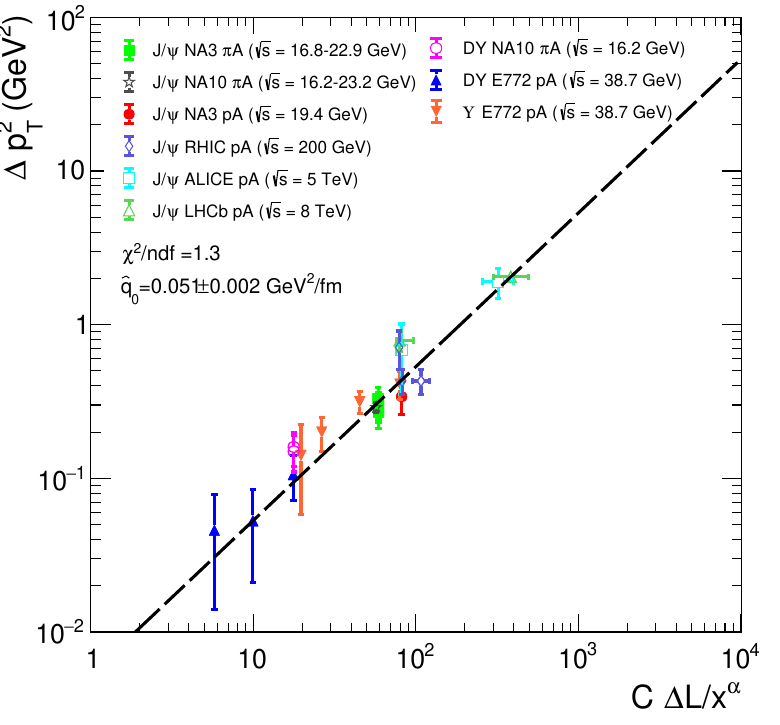
Figure 2 . Scaling of the nuclear p assumptions in table